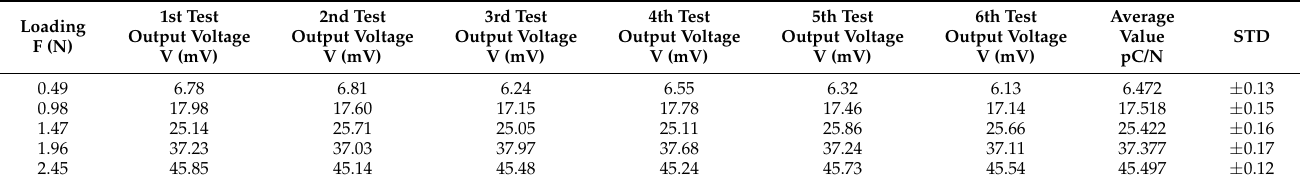
Table 5. Output voltage of the same sensor under identical